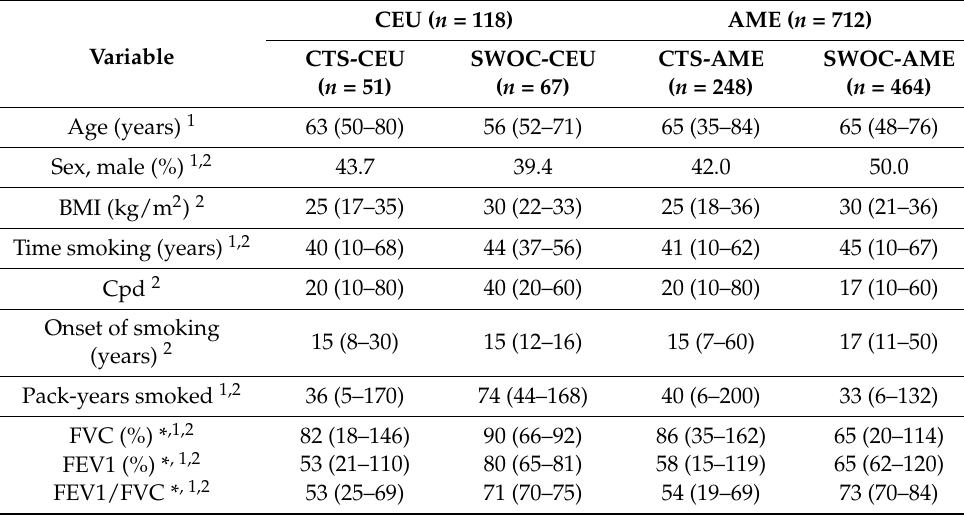
Table 2. Demographic and clinical variables of the study